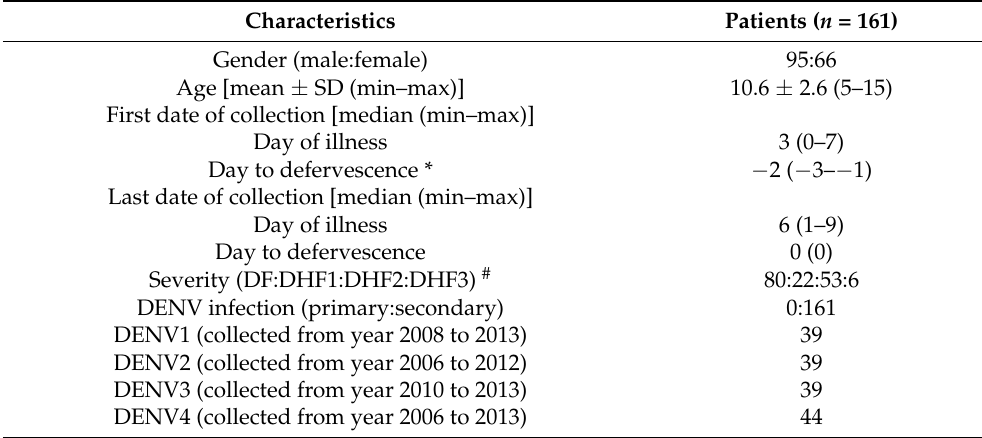
Table 1. Patient characteristics in this study.